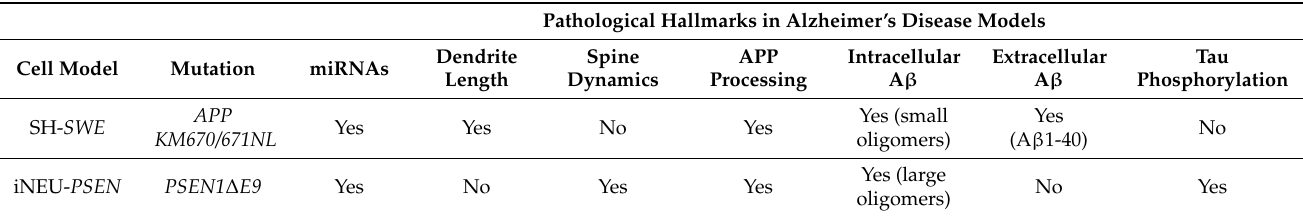
Table 1. Comparative pathological characteristics of human SH- SWE and iNEU- PSEN neuronal AD models in research. Pathological Hallmarks in Alzheimer’s Disease